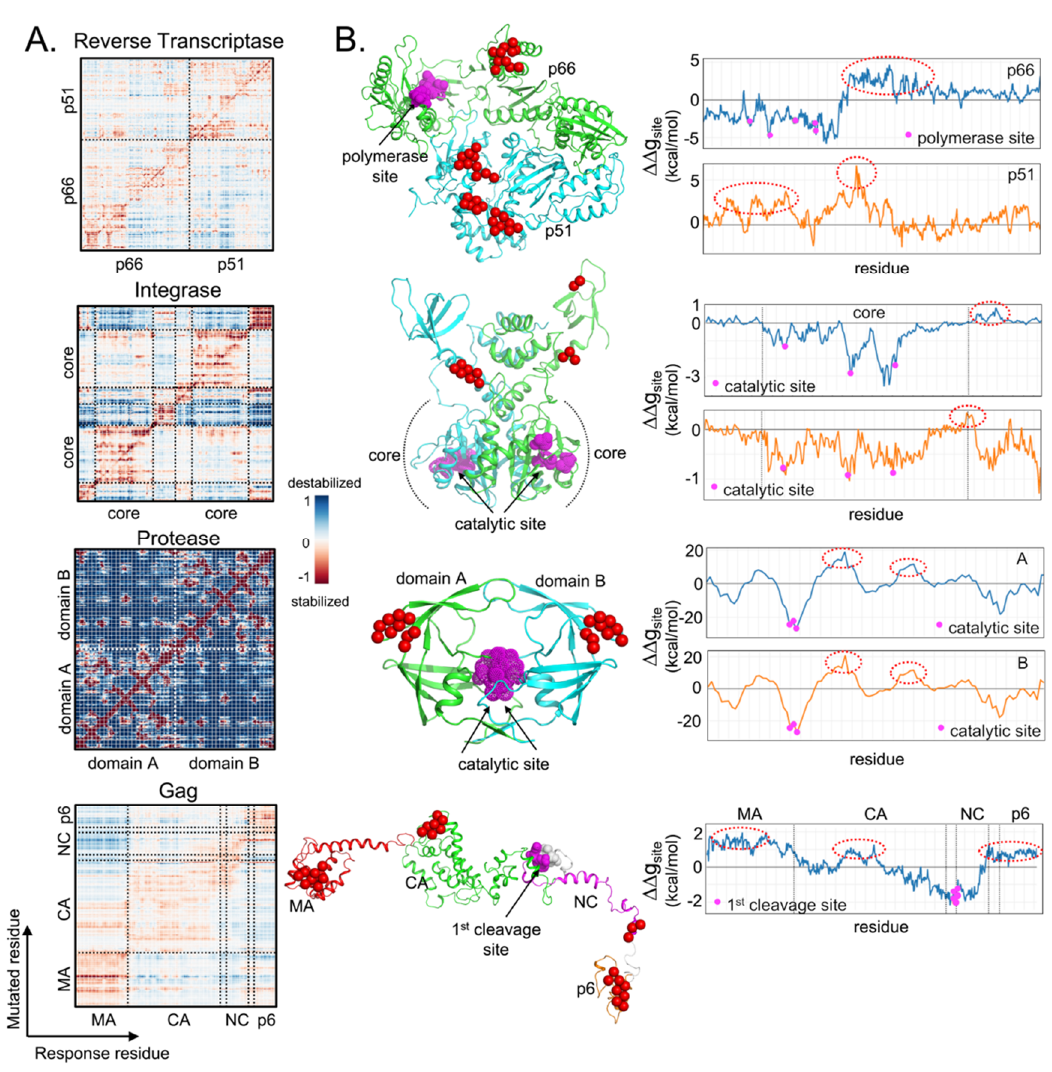
Figure 2. Underlying allosteric communications were found within HIV-1 proteins. ( A ) Allosteric signaling maps (single-point mutation screening) of HIV-1 Reverse Transcriptase, Integrase, Protease, and Gag. Structural presentation using RT (pdb 3T19), IN (reconstructed from pdb 1K6Y and 1EX4), PR (pdb 2PC0), and Gag model from Su et al. [87]; ( B ) Allosteric-free energies ( ∆∆ g site ) on specific catalytic or cleavage sites (magenta spheres) were estimated based on individual perturbations at single residues (x-axis) to demonstrate the resulting stabilizing ( ∆∆ g site < 0) or destabilizing ( ∆∆ g site > 0) effects. The possible mutations which may potentially destabilize the sites of interest, are highlighted in red spheres and red dash ovals.